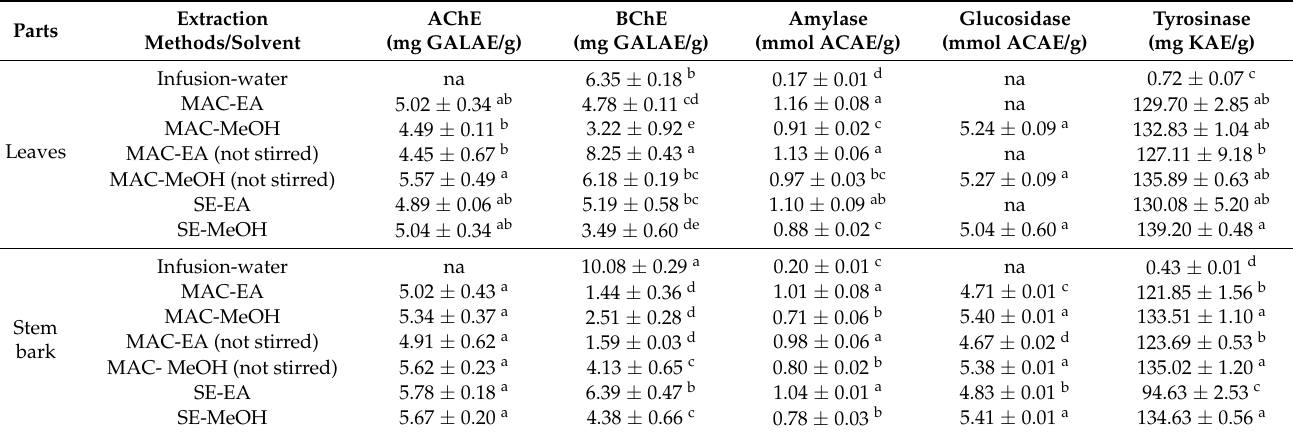
Table 9. Enzyme inhibitory properties of the studied extracts